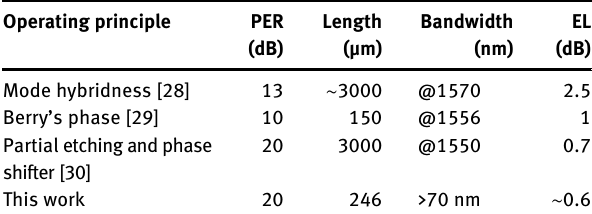
Table  : Summary of polarization switches on silicon. Operating